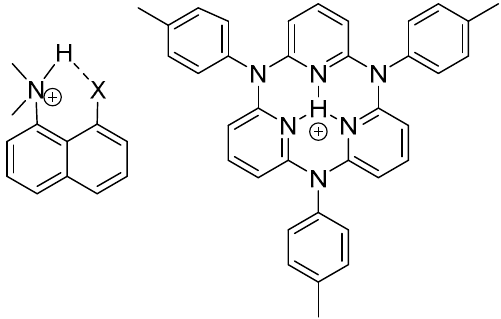
Figure 2. Non ‐ RAHB system. The left hand molecule with X=N(CH 3 ) 2 is the well known DMANH + proton sponge. With X=pyrrole in Figure 4 hydrogen bonding to the π‐ electron system is found, [7] whereas with X=N(CH 3 )C=OCH 3 hydrogen bonding to nitrogen have been tested [8]. The right hand molecule, N,N ′ ,N ″‐ tris(p ‐ tolyl)azacalix [3](2,6)pyridine (TAPH), shows an extremely low field NH proton chemical shift of 22.1 ppm [9,10].